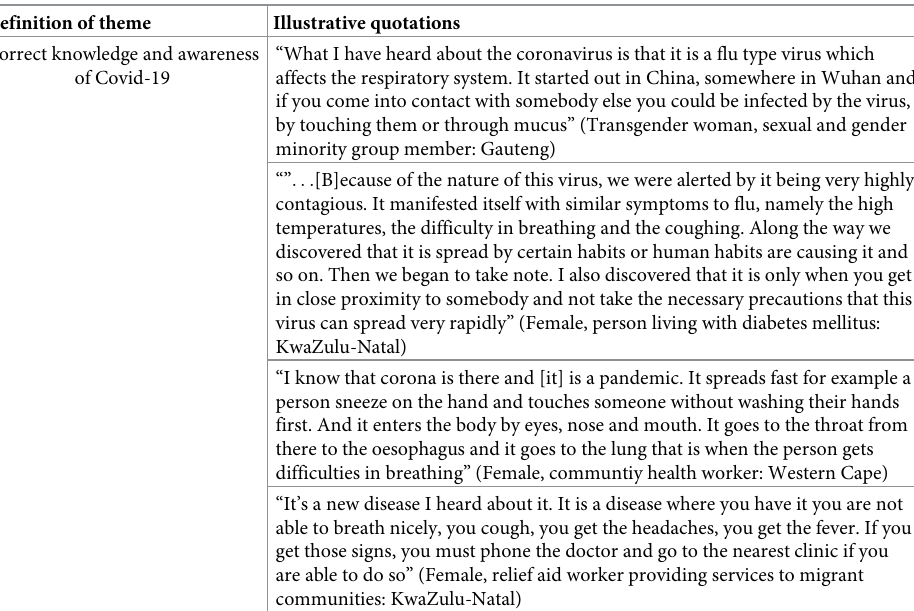
Table 1. Knowledge of